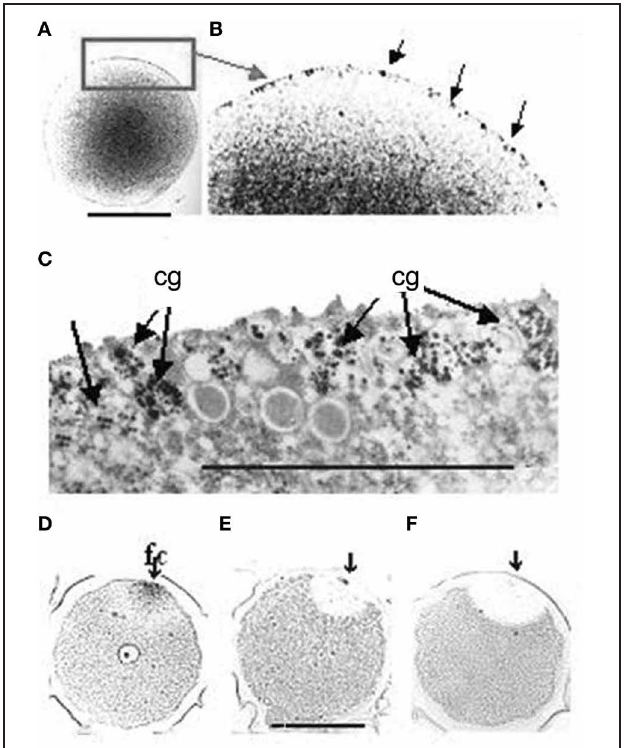
FIGURE 2 | (A) AChE-positive vesicles in sea urchin ovarian eggs. 5 μ m section, antibody anti AChE (Sigma, IT); bar equals 20 μ m. (B) Electron microscopy image, showing AChE activity localized in cortical vesicles and granules in unfertilized eggs ( × 20.000).